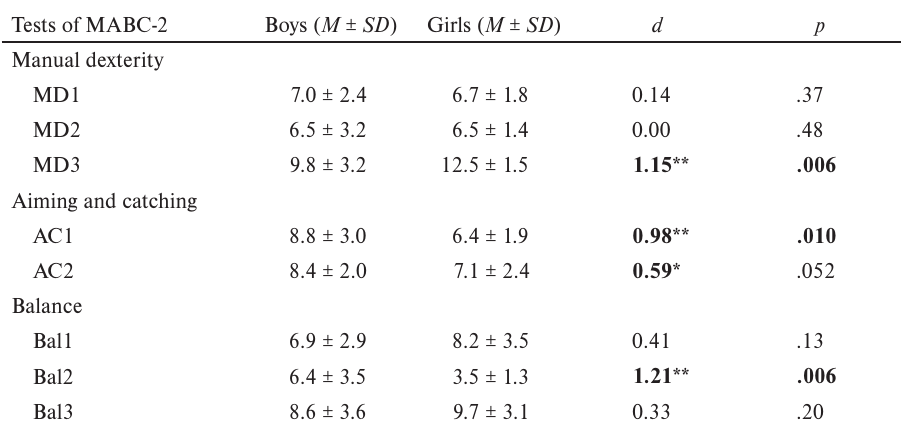
Table 4 Gender differences in standard score in each test of MABC-2 in children with rDCD Tests of